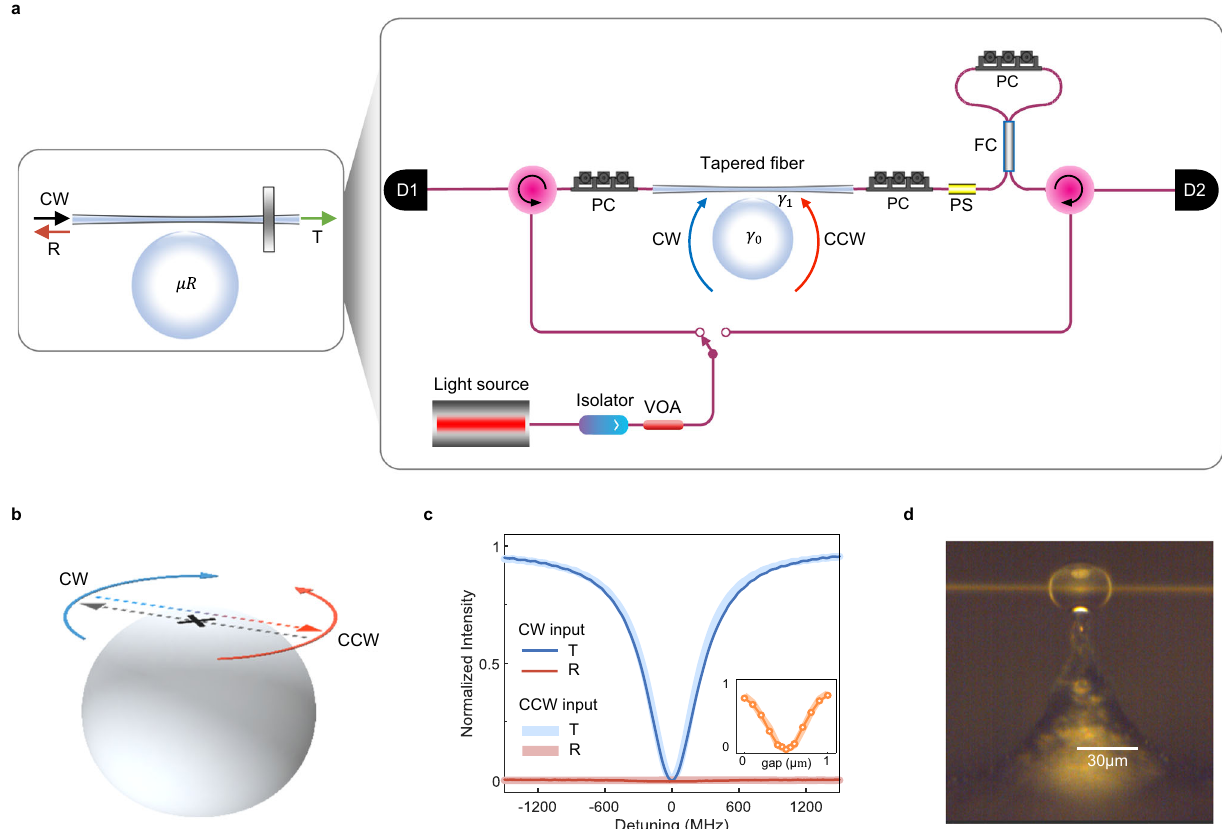
Fig. 1 Experimental setup for tunable unidirectional coupling between CW and CCW modes of a microresonator. a A partially re fl ecting mirror placed at only one end of a waveguide (end-mirror) in a waveguide-coupled microresonator ( μ R ) system unidirectionally couples the frequency-degenerate clockwise (CW) and counter-clockwise (CCW) modes of the resonator. Such an end-mirror with tunable re fl ection coef fi cient is implemented as a fi ber- loop mirror using a fi ber coupler (FC) and polarization controller (PC). γ : waveguide-resonator coupling loss; γ : sum of all resonator-related losses such 1 0 as radiation, scattering, and material losses; D1 & D2: photodetector; VOA: variable optical attenuator. b In the setup in ( a ), the CW mode couples to the CCW mode, but the CCW mode does not couple to the CW mode. This unidirectional (nonreciprocal) coupling between the CW and the CCW modes of the resonator creates an exceptional surface (ES). Controlling the phase and the magnitude of the re fl ected light from the end-mirror allows steering the system on the ES. c Without the end-mirror, the system has symmetric Lorentzian transmission (blue) and re fl ection (red) spectra for left and right incidence (CW and CCW inputs). Zero-re fl ection and the absence of mode splitting in the transmission spectra for both input directions imply the absence of intermodal coupling between the modes. The inset shows that the loading curves are also the same, and the system can be tuned from the overcoupling to the undercoupling regime through the critical coupling point. d Optical image of the tapered- fi ber coupled on-chip microsphere resonator used in the ffiffiffiffiffi p κδ , and push the system off the ES.